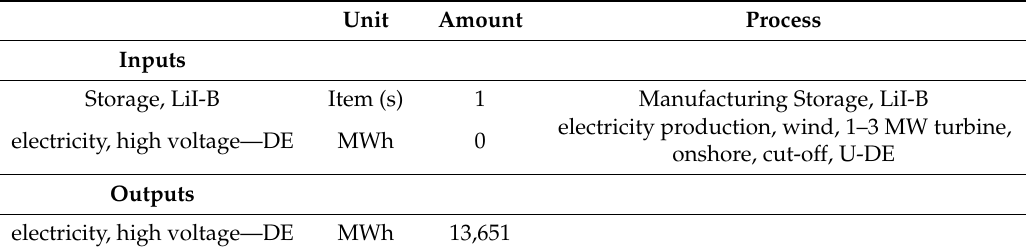
Table A26. Use Storage, LiI-B.